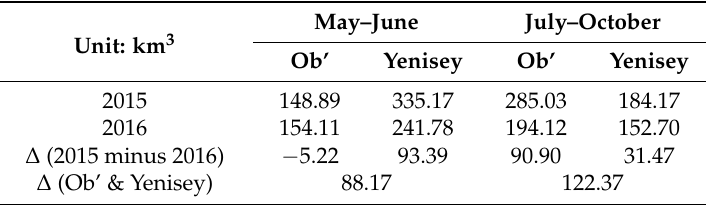
Figure 8. Daily river discharge from ( a ) Ob’ and ( b ) Yenisey Rivers during May 2015 to April 2016 (black) and from May 2016 to April 2017 (red). Table 2. Comparison of Ob’ and Yenisey River integrated discharge for the warm seasons of 2015 and 2016.